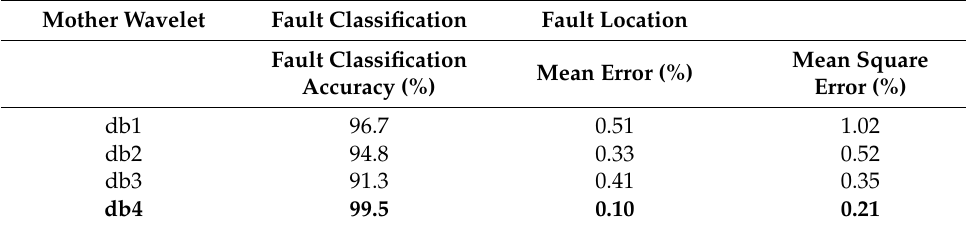
Table 3. Mother wavelet selection